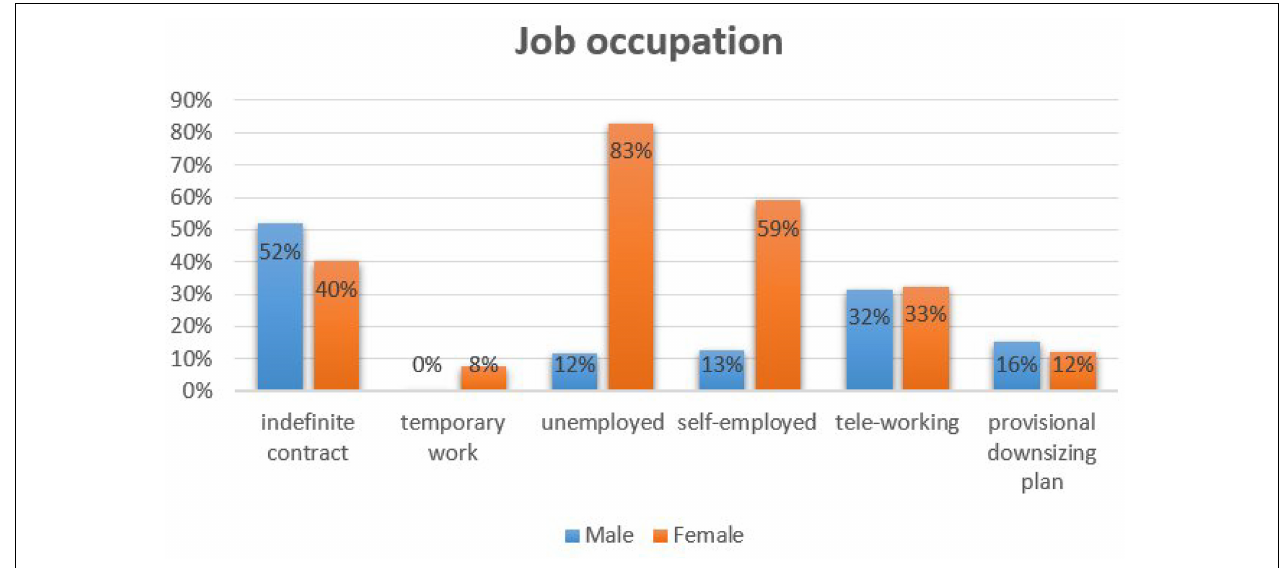
FIGURE 1 | Progenitor employment